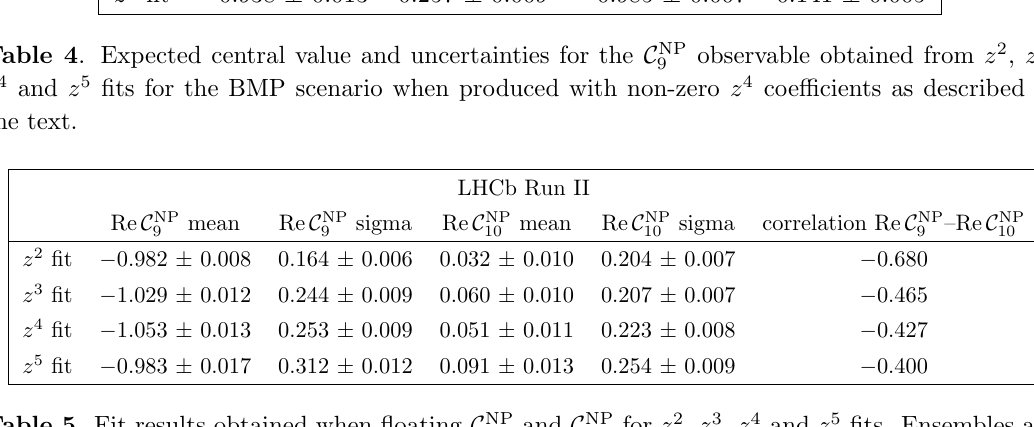
Table 5 . Fit results obtained when (cid:13)oating C NP produced for the BMP scenario with the corresponding statistics expected at the LHCb Run